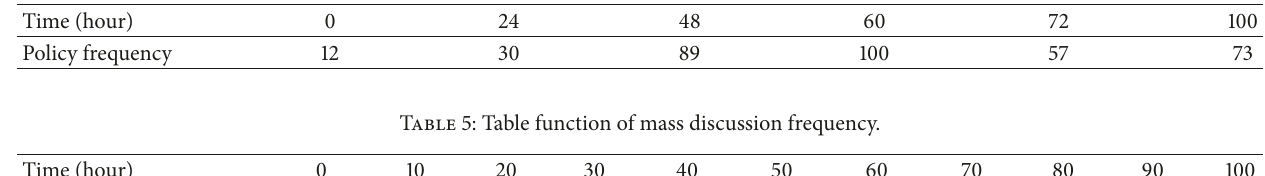
Table 4: Table function of policy frequency.